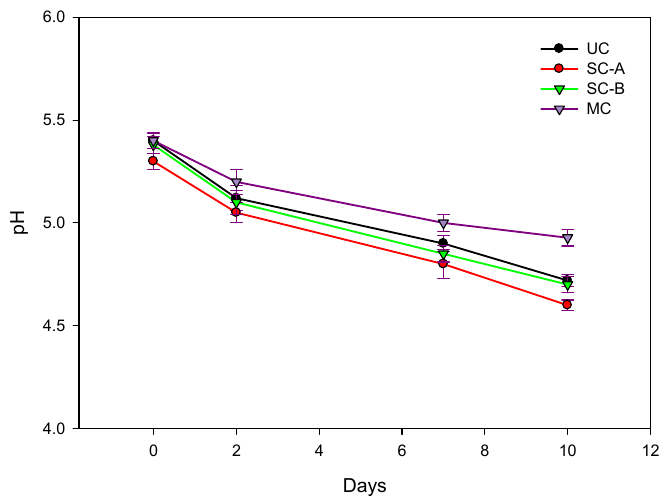
Figure 3. pH values of sliced cherimoya with different treatments: uncoated samples (UC), single coating A (SC-A), single coating B (SC-B), and multilayered coating (MC). N = 3; data shown are mean ± standard deviation.